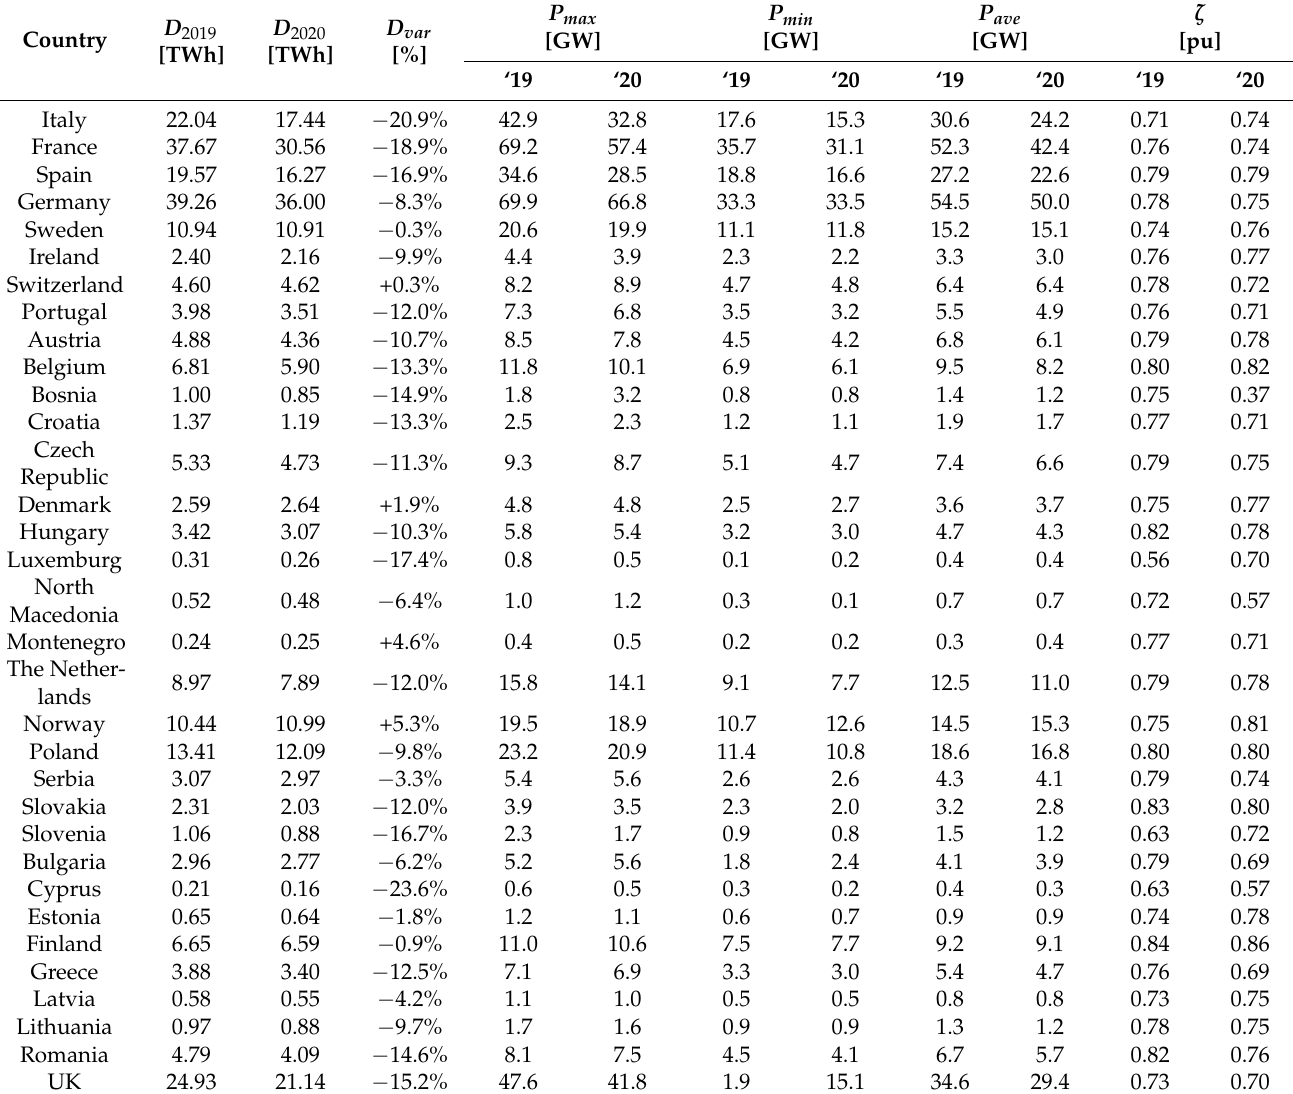
Table A1. Energy consumption, energy demand variation ( D var ) , maximum ( P max ) , minimum ( P min ) and average ( P ave ) power demanded, and the load factor ( ζ ) for some European countries, April 2019–2020 (in blue the EU countries).